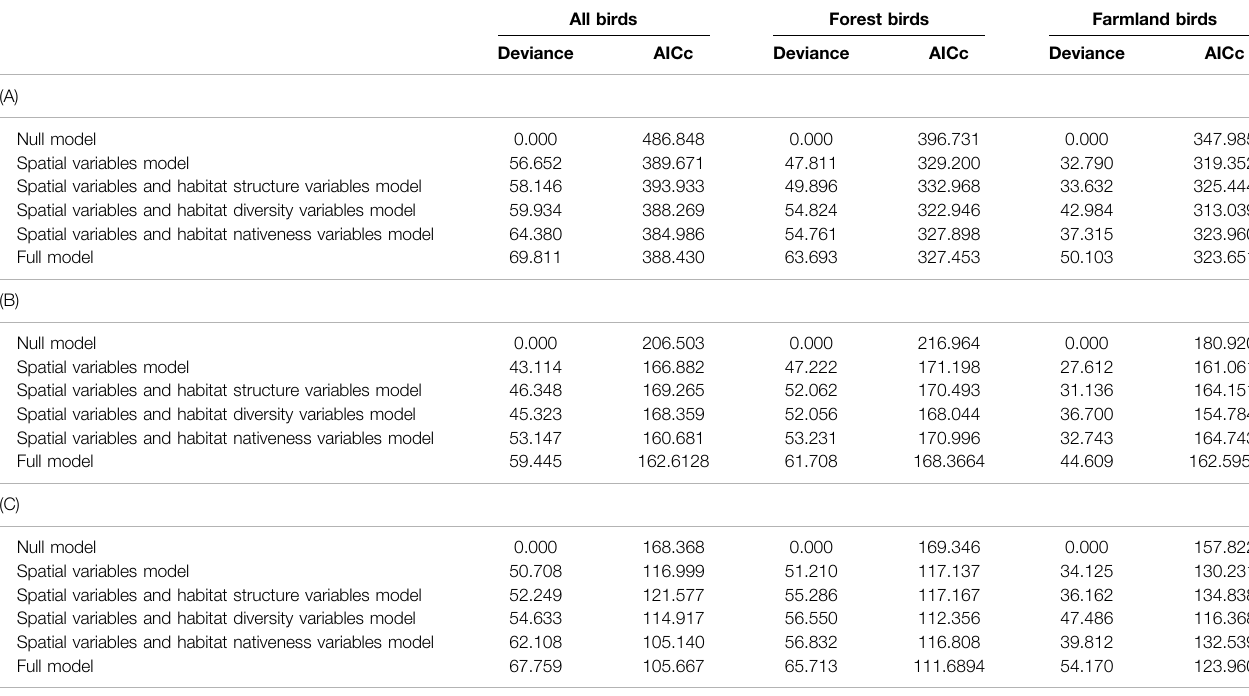
TABLE 2| Explained deviance and AICc ofsixgeneralized linear models explaining (A)species richness, (B) rari fi ed species richness, and (C) the Shannon diversity index for all, forest and farmland bird species. For speci fi c variables categorized as spatial, habitat structure, diversity and nativeness see Table 1 . All birds Forest